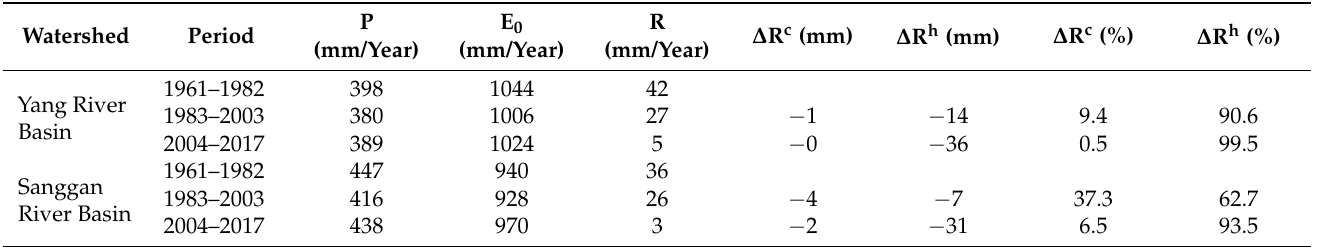
Table 2. Effects of climate change and human activities on streamflow in the UYRB with the Budyko method.